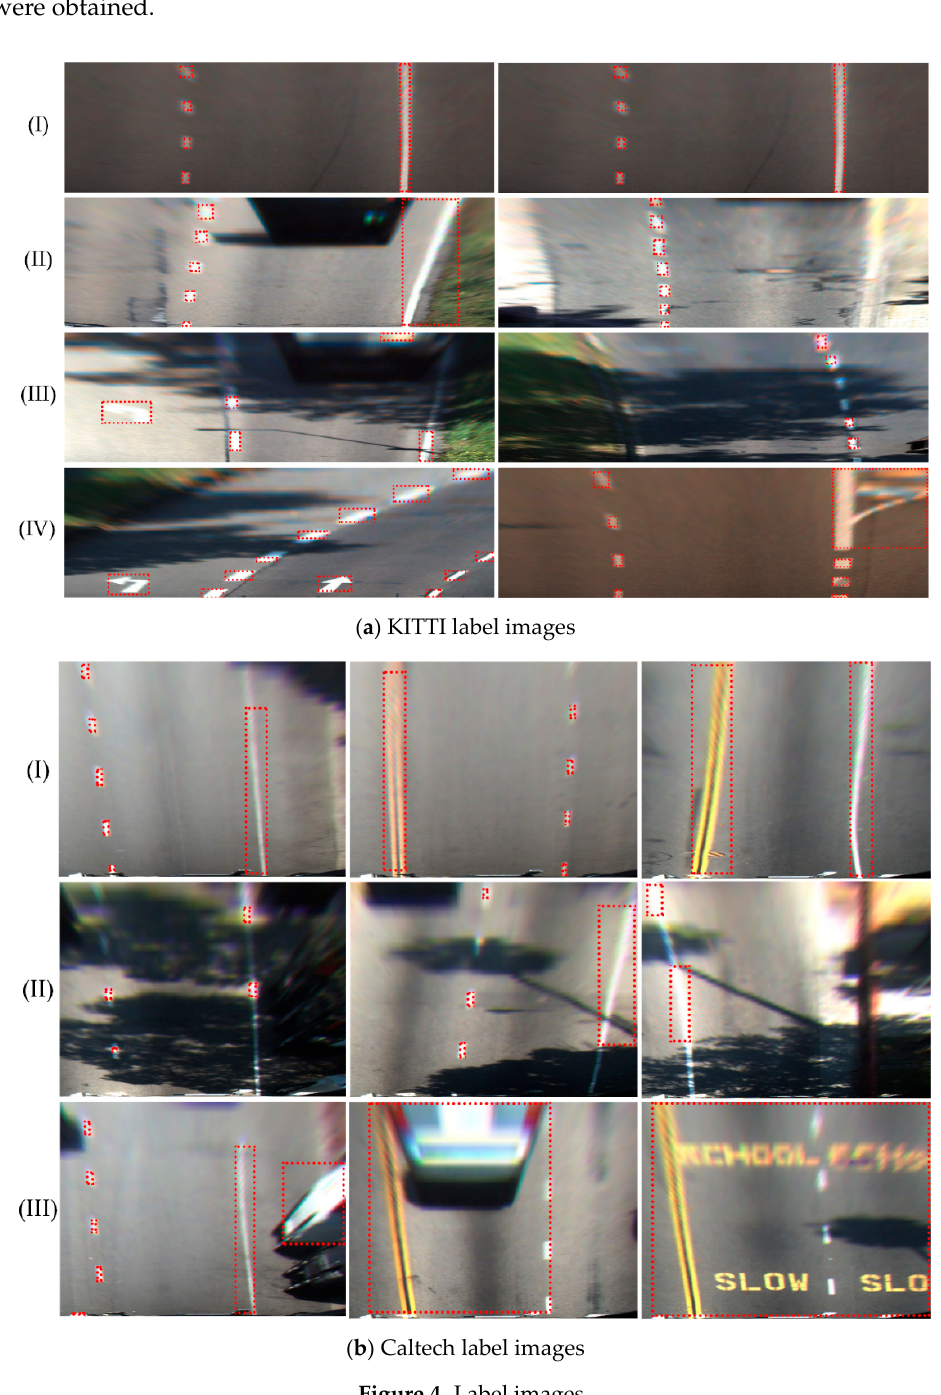
Figure 4. Label images.